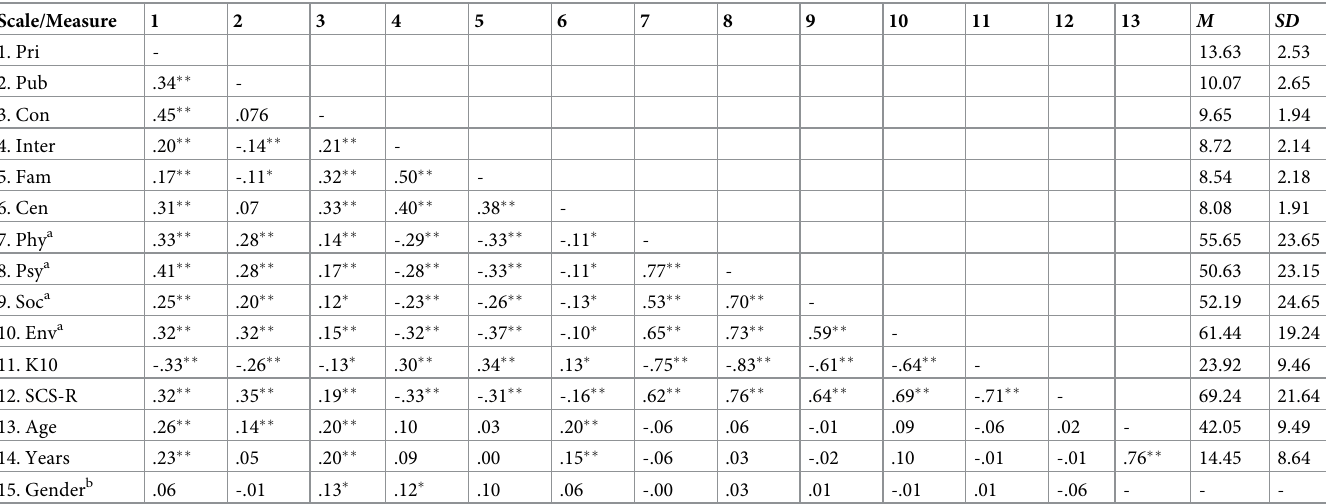
Table 3. Correlations between 20-item six-factor Warrior Identity Scale and outcome variables, means, and standard deviations.